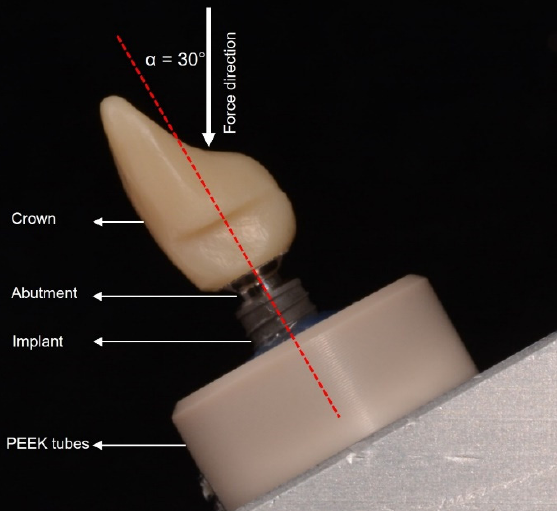
Figure 4. Standardized photograph showing one sample before chewing simulation. The red dotted line represents the long axis of the implant and the crown.